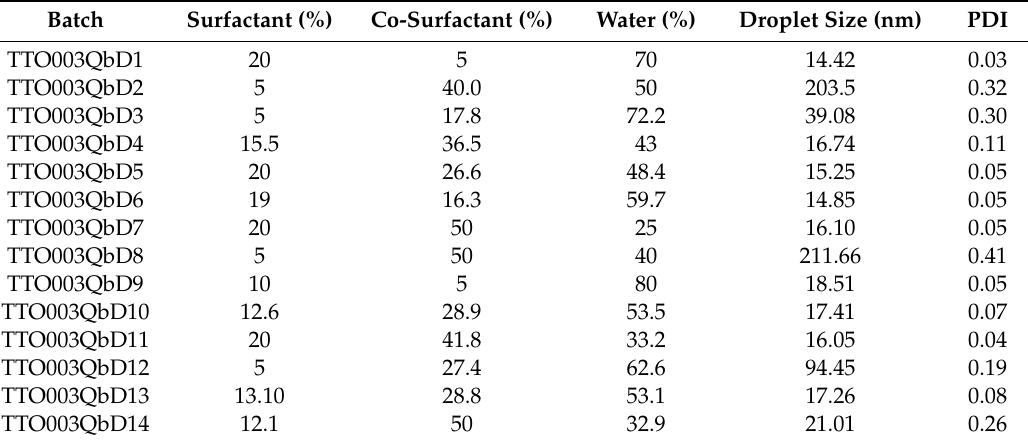
Table 2. Mixture Experimental Design batch and results.